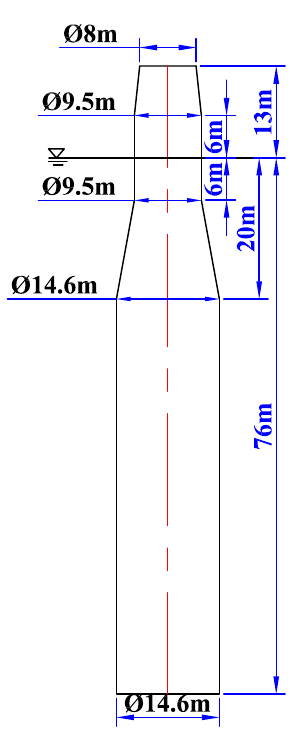
Figure 10. Spar platform of the 6MW spar-type FOWT.